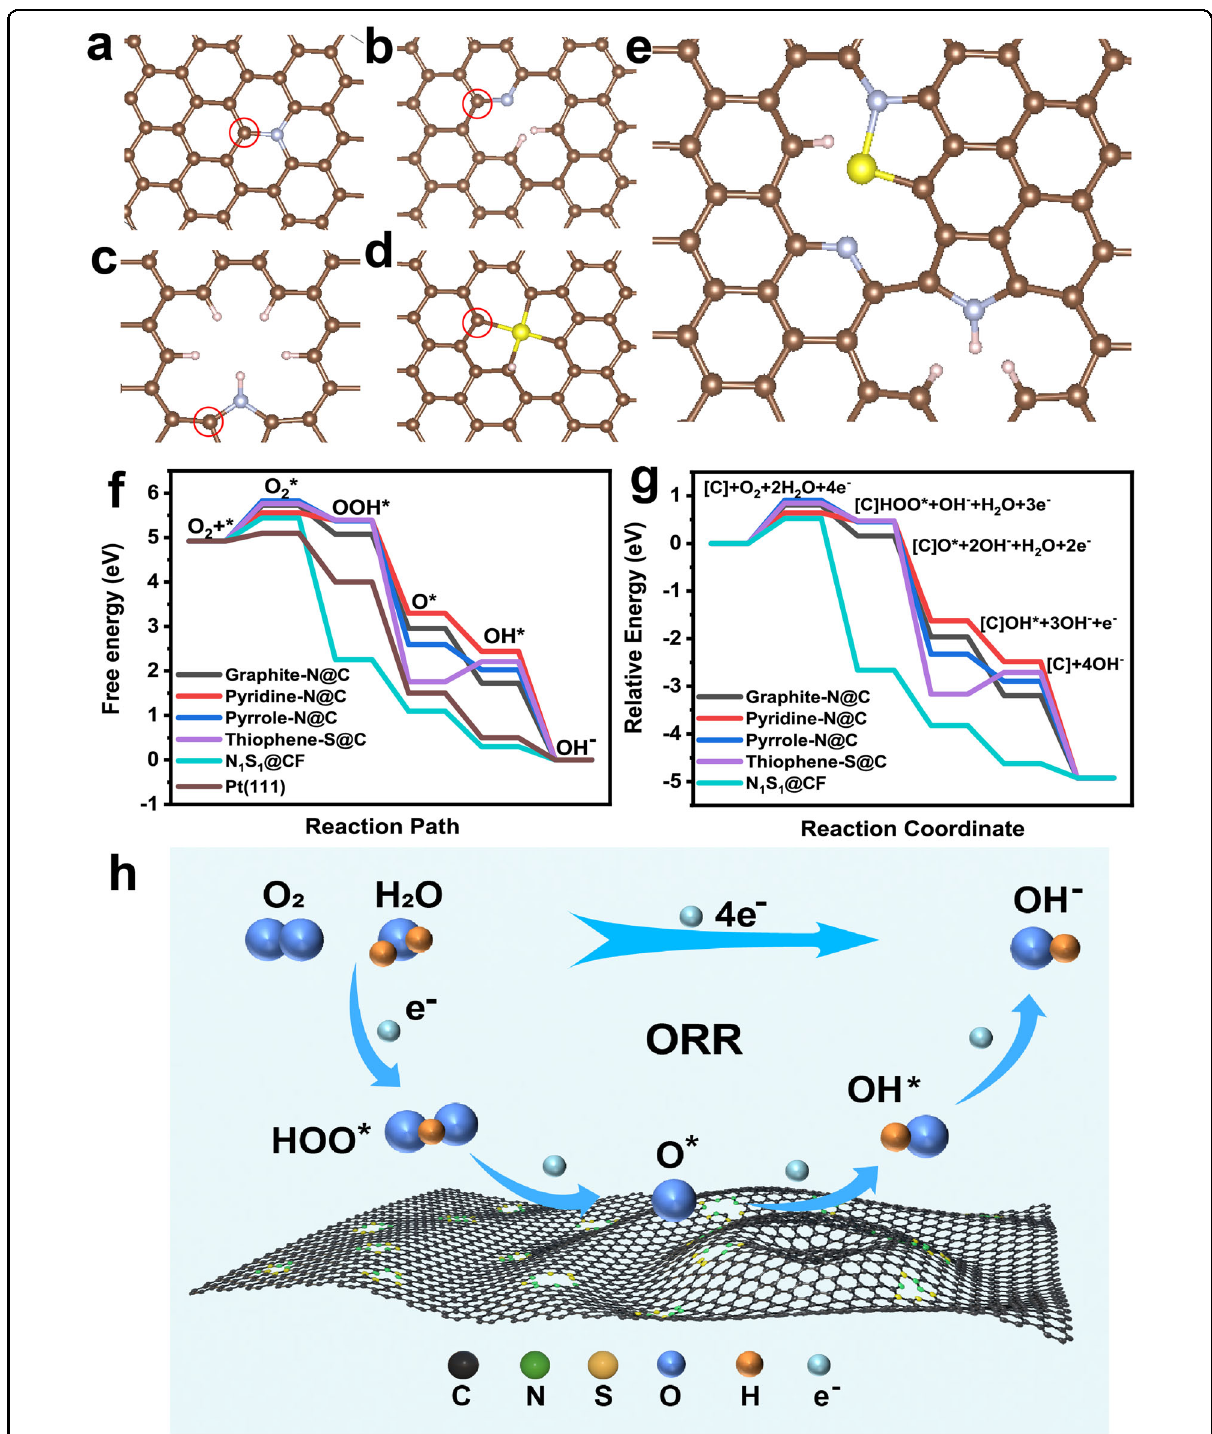
Fig. 6 Density functional theory calculations and analysis of N 1 S 1 @CF. Schematic structures of a graphite-N@C, b pyridine-N@C, c pyrrole-N@C, d thiophene-S@C, and e N 1 S 1 @C with the active sites used for the calculations marked by red circles, and ORR Gibbs free energies ( f ) and relative energies ( g ) are indicated. h Schematic representation of the electron transfer pathway for the